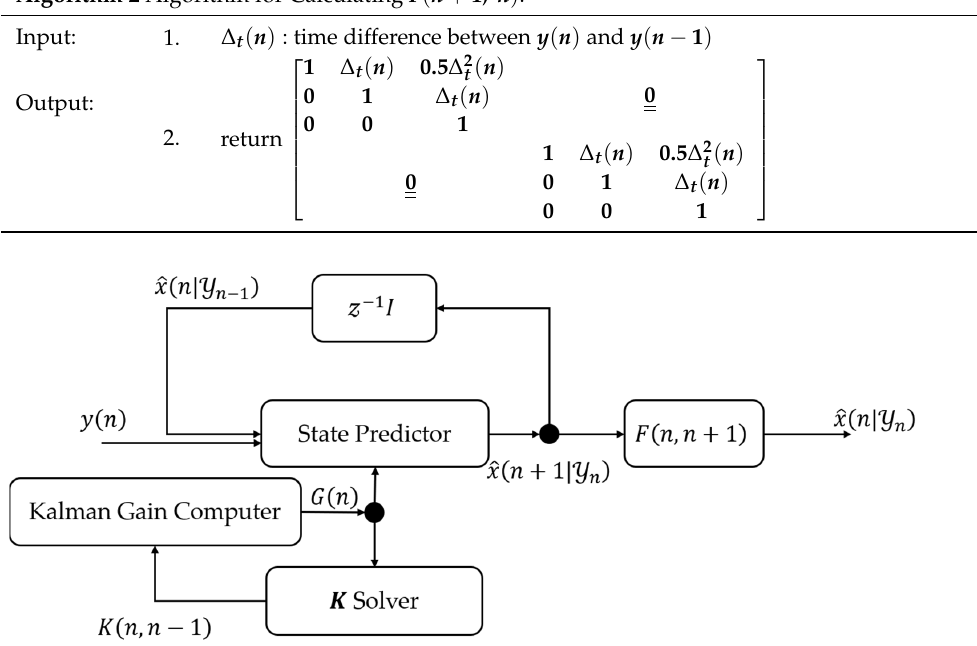
Algorithm 2 Algorithm for Calculating F ( n + 1 , n ) .